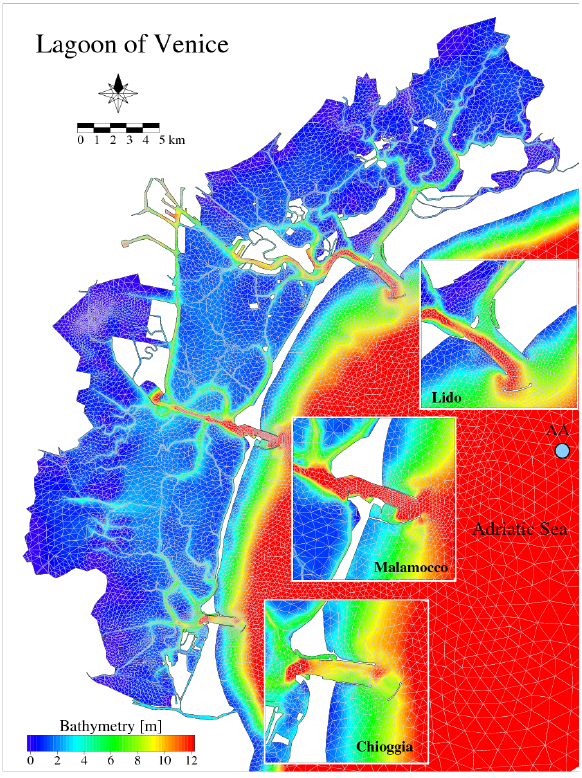
Fig. 2. Bathymetry (referred to IGM42 datum) of Venice Lagoon in the present situation (2012) and adjacent shore obtained by using finite element model grid (superimposed). The circle indicates the location of oceanographic tower Acqua Alta